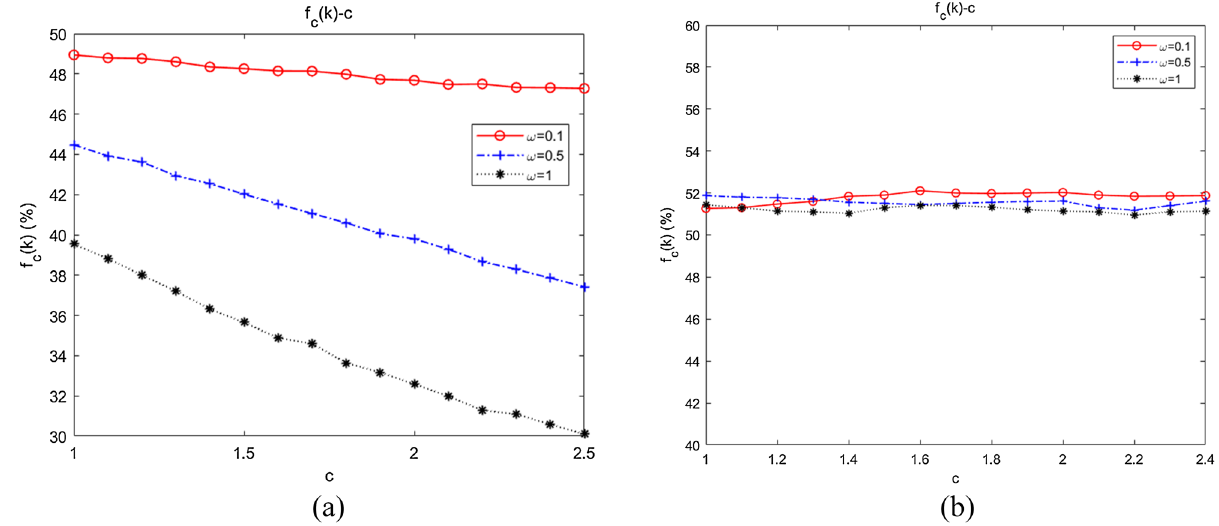
Figure 11. Relationship between average abundance and cost. ( a ) Defection strategy dominates; ( b ) collaboration strategy